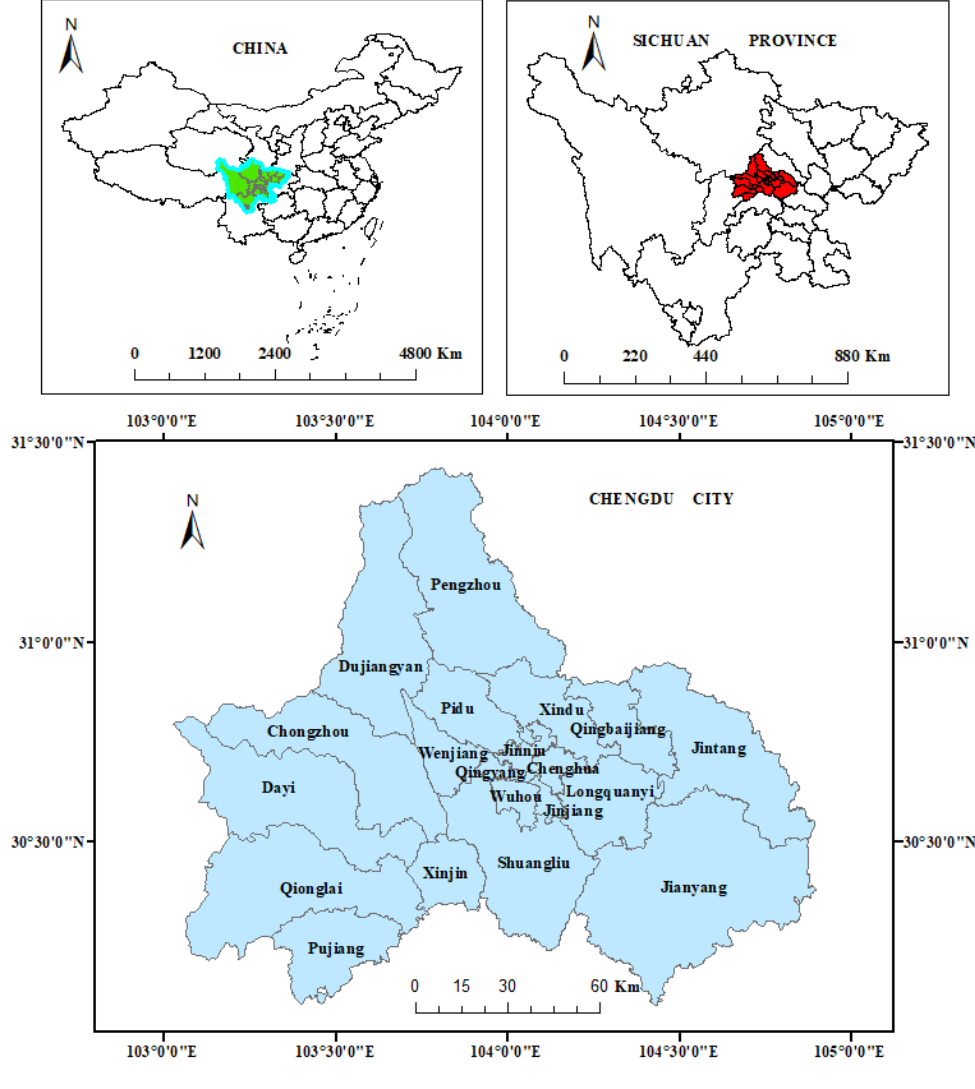
Figure 1. Location of